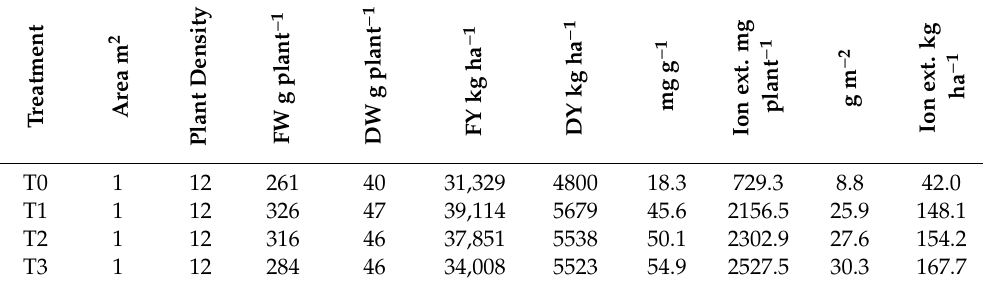
Table 4. Ion extraction from the soil by Tetragonia tetragonioides , (Na) kg ha − 1 .